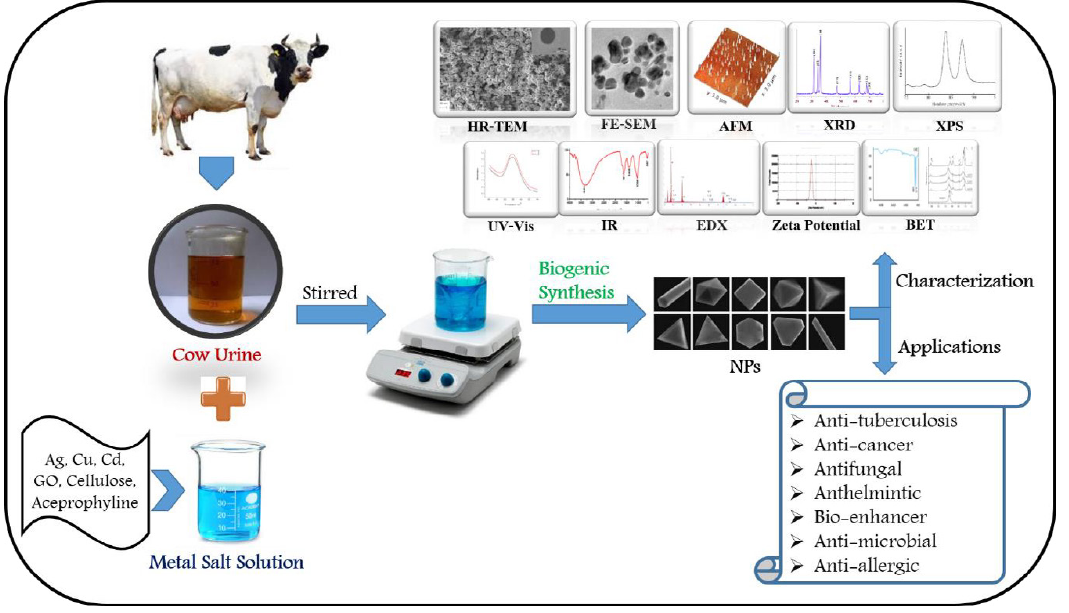
Fig. 4. Biogenic synthesis of NMs from cow urine and their uses